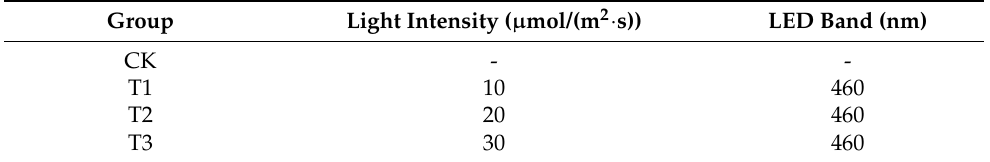
Figure 1. LED equipment diagram. Table 1. Freshly cut amaranth of each experimental group.